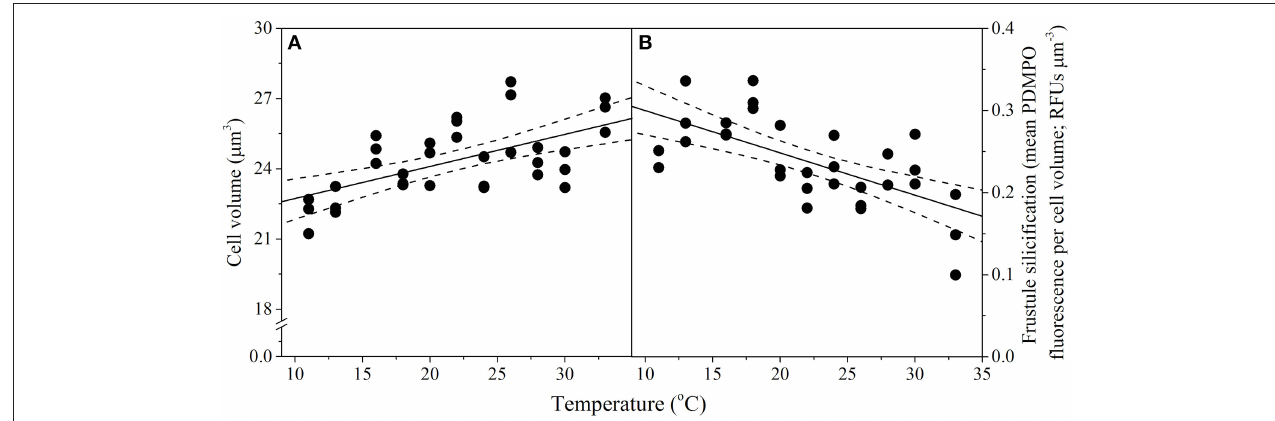
FIGURE 3 | Thermal performance curves of morphological traits in the diatom Thalassiosira pseudonana depicting (A) cell volume ( n = 33, p < 0.01, R 2 = 0.34); and (B) frustule silicification ( n = 31, p < 0.01, R 2 = 0.41), as a function of temperature. Each symbol represents a distinct biological replicate. The solid line corresponds to maximum likelihood estimate with broken lines corresponding to the 95% confidence intervals of a linear regression both estimated by parametric bootstrapping.